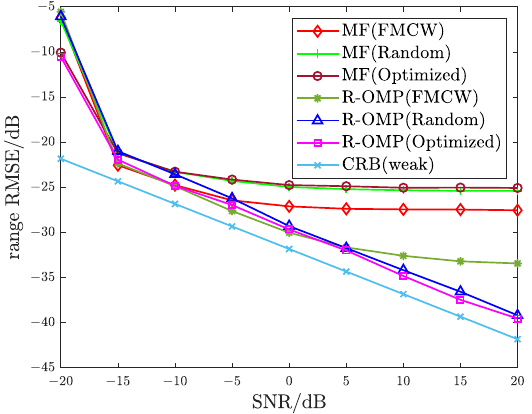
Figure 13. Range RMSE of strong